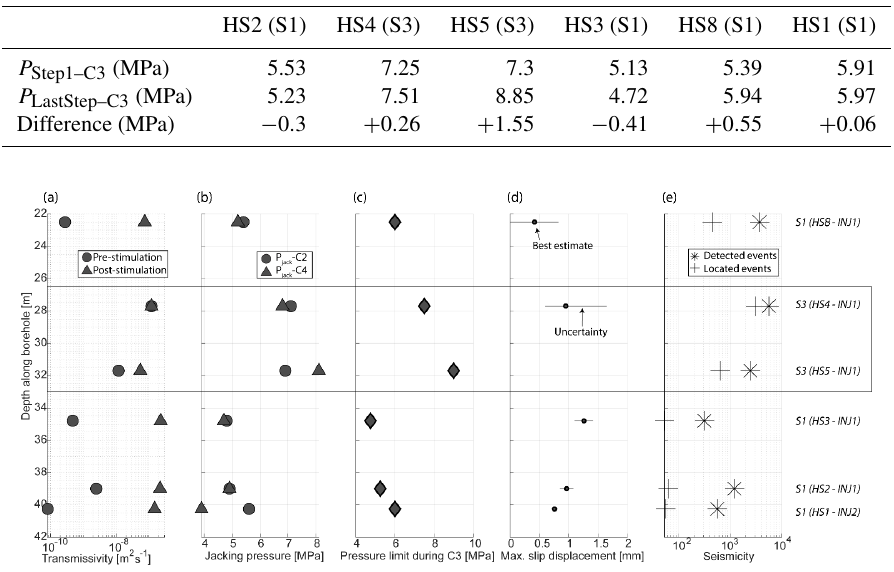
Table 3. Injection pressures measured at the end of the first and last (before shut-in) injection steps of the stimulation injection cycle (C3). The difference between the two values is listed in the lower row.